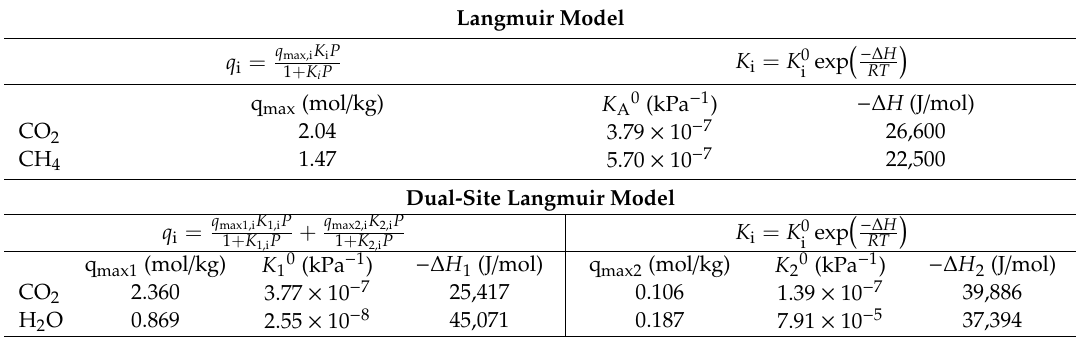
Table 3. Langmuir and dual-site Langmuir fitting parameters for CH 4 , CO 2 , and H 2 O adsorption on ZSM-5 extrudates.